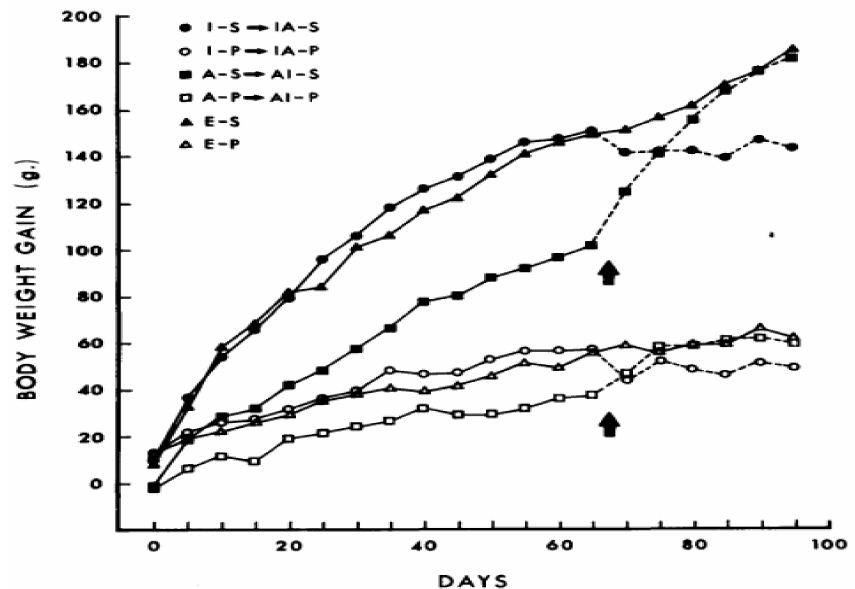
Figure 3. The effect of supplementary palatable “supermarket” food (S) compared to standard Purina chow (P) on weight gain in laboratory rats housed singly (I), in cages allowing exploration and climbing (E), or cages equipped with activity wheels (A). Presence of activity wheels suppressed, but did not eliminate dietary obesity. From Sclafani, Springer. Dietary obesity in adult rats: Similarities to hypothalamic and human obesity syndromes. Physiol. Behav. 1976, 17, 461–471, doi:org/10.1016/0031-9384(76)90109-8, with permission from the publisher